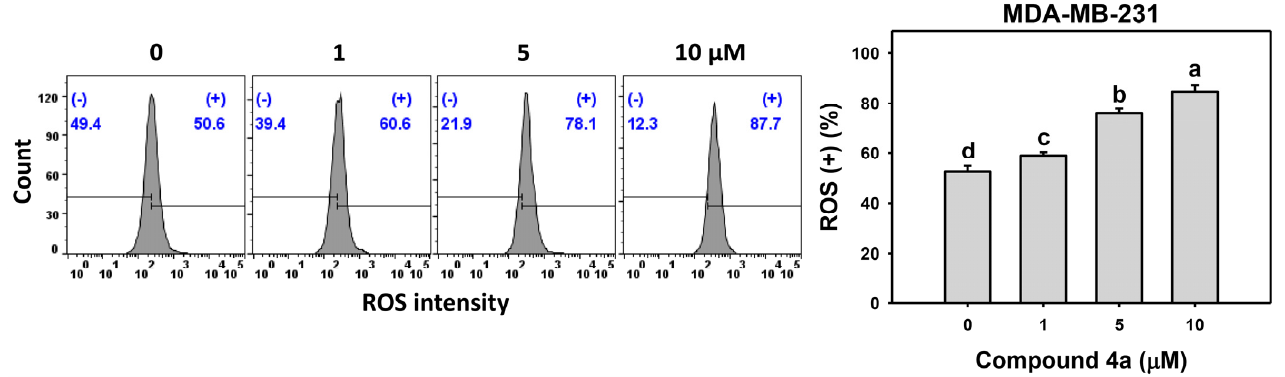
Figure 4. ROS levels of breast cancer cells were induced by compound 4a . MDA-MB-231 cells were treated with 4a for 24 h. ROS levels were determined by flow cytometry. Populations of high ROS intensities were assigned as ROS (+) (%). Data, means ± SDs ( n = 3). Data containing non-overlapping notes exhibited significant differences ( p < 0.05). The letters (a, b, c, d) were provided by the statistical JMP software for determine significance. “a” is the biggest value and others follow the order.